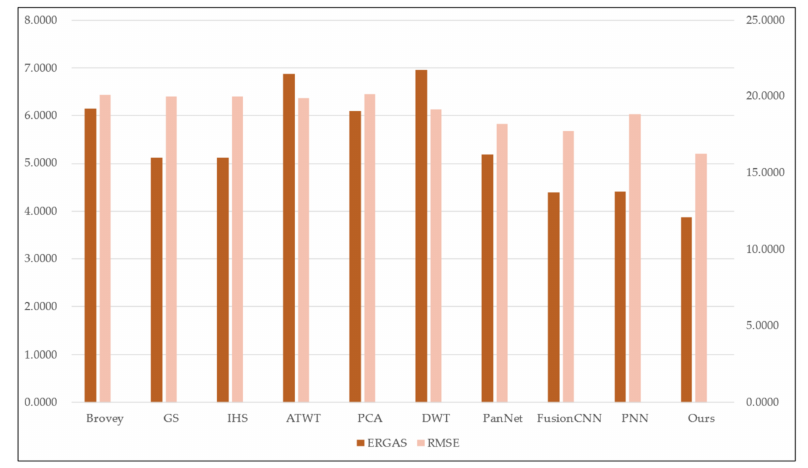
Figure 10. Histogram results of the first group of evaluation indexes.